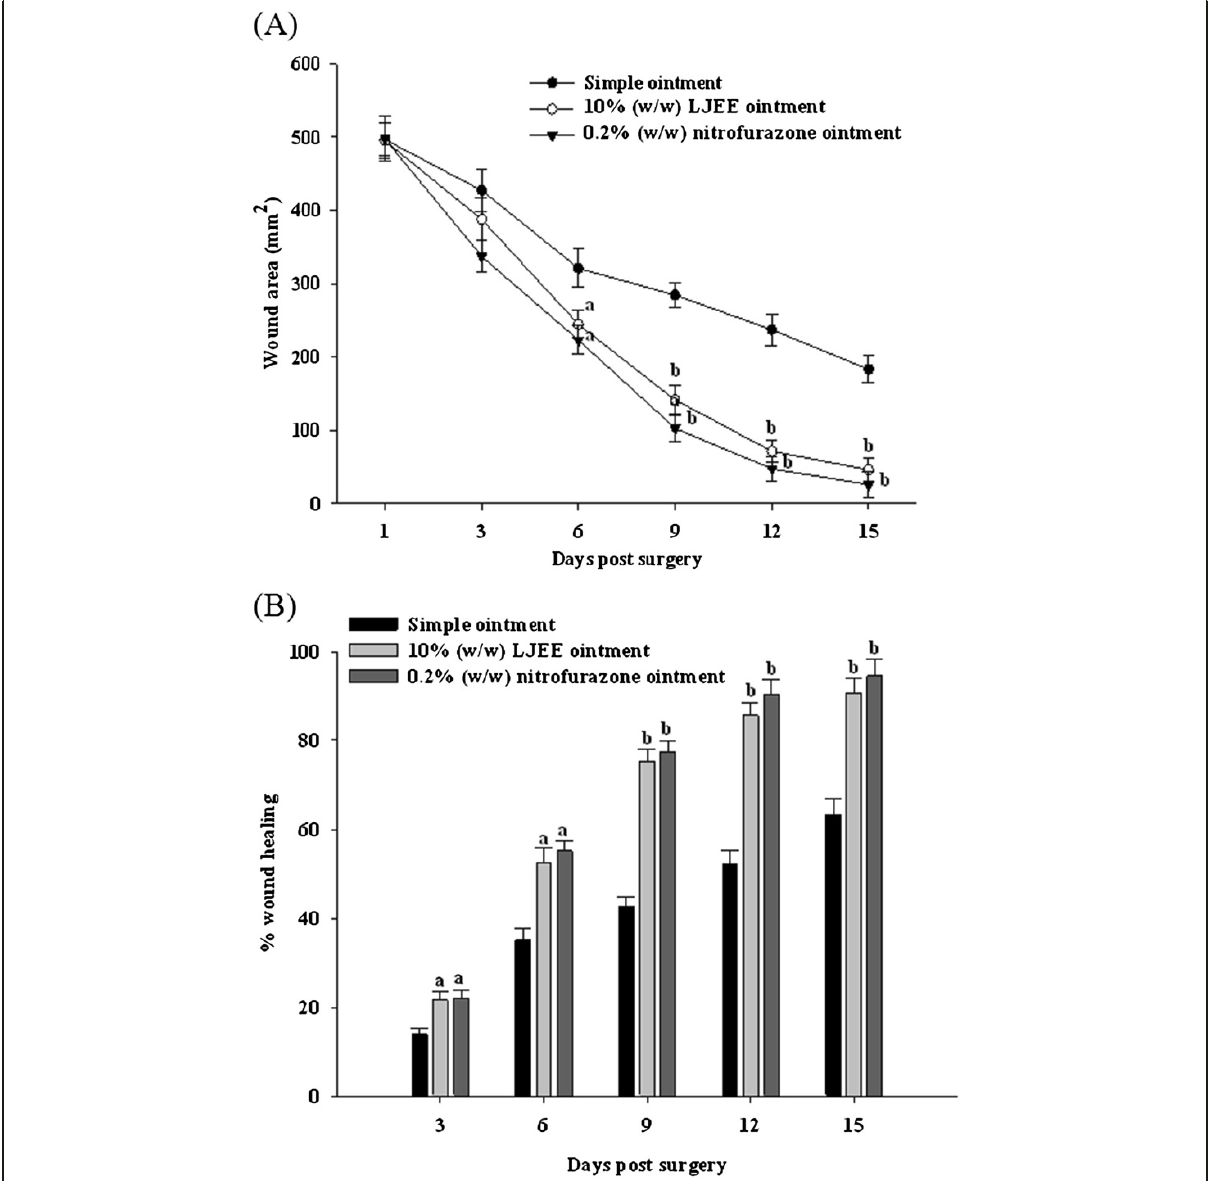
Figure 2 Effect of LJEE ointment on the wound area (A) and the percentage of wound contraction (B) in excision wound models on different days after wounding. Values (mean ± SD) were obtained for each group of eight rats. a P < 0.05 and b P < 0.01 compared to the values of simple ointment-treated rats on the indicated day in each